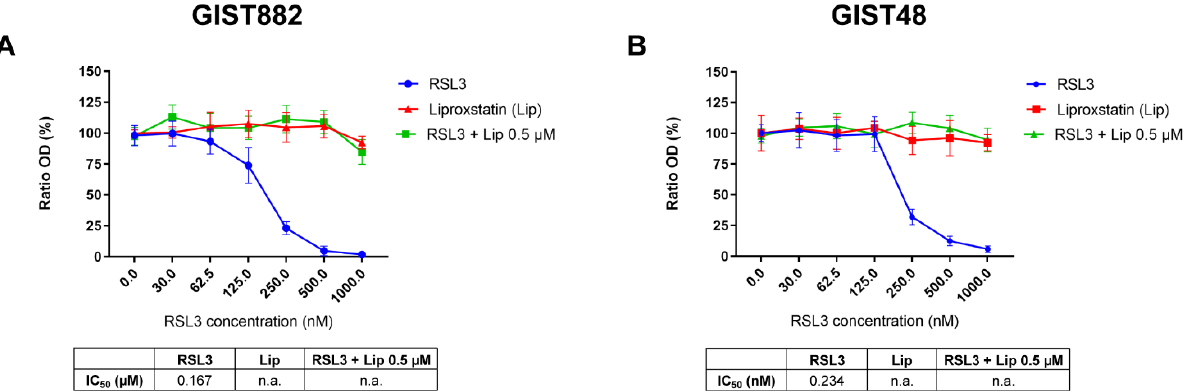
Figure 1. The class II ferroptosis inducer RSL3 drastically reduces GIST882 and GIST48 cell viability, which is completely rescued by the antioxidant liproxstatin. ( A ) WST-1 viability assays in GIST882 and ( B ) in GIST48 cells. Cells were treated for 3 h with RSL3 (0 to 1000 nM), liproxstatin (Lip) (0 to 2000 nM), or with a combination of different concentrations of RSL3 (0 to 1000 nM) and 0.5 μM of Lip. IC50 values are shown in tables under the viability graphs. Mean values ±SD are shown for three independent experiments with three technical replicates for each experiment.